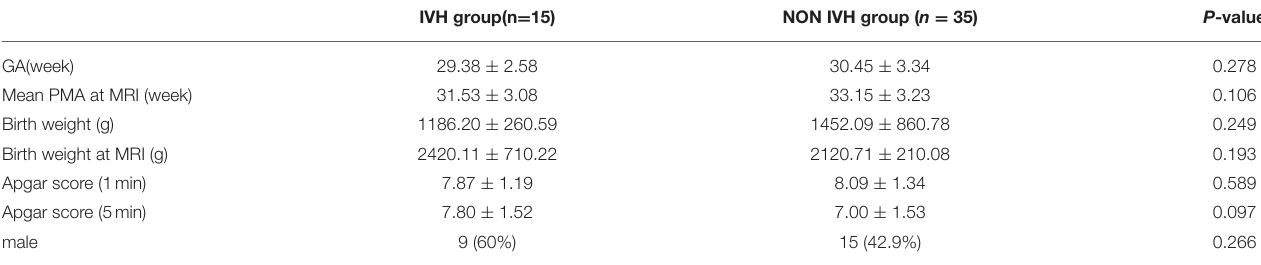
TABLE 1 | Demographic characteristics.